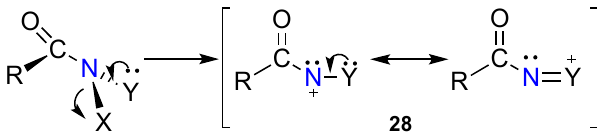
Molecules 2018 , 23 , x FOR PEER REVIEW